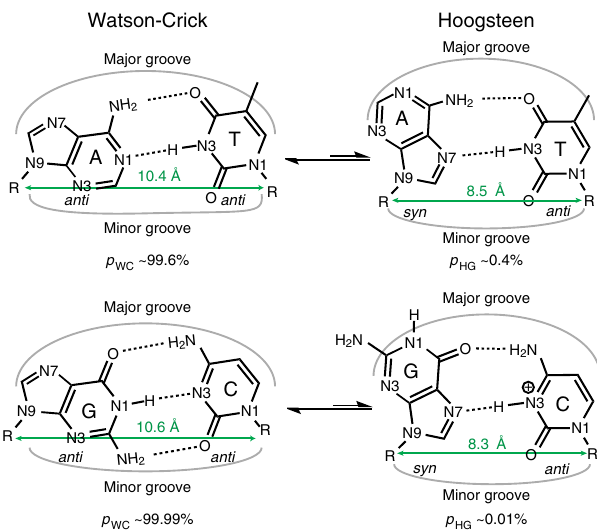
Fig. 1 Dynamic equilibrium between Watson-Crick and Hoogsteen base pairs. The abundances of both G – C and A – T Hoogsteen at neutral pH were taken from ref.